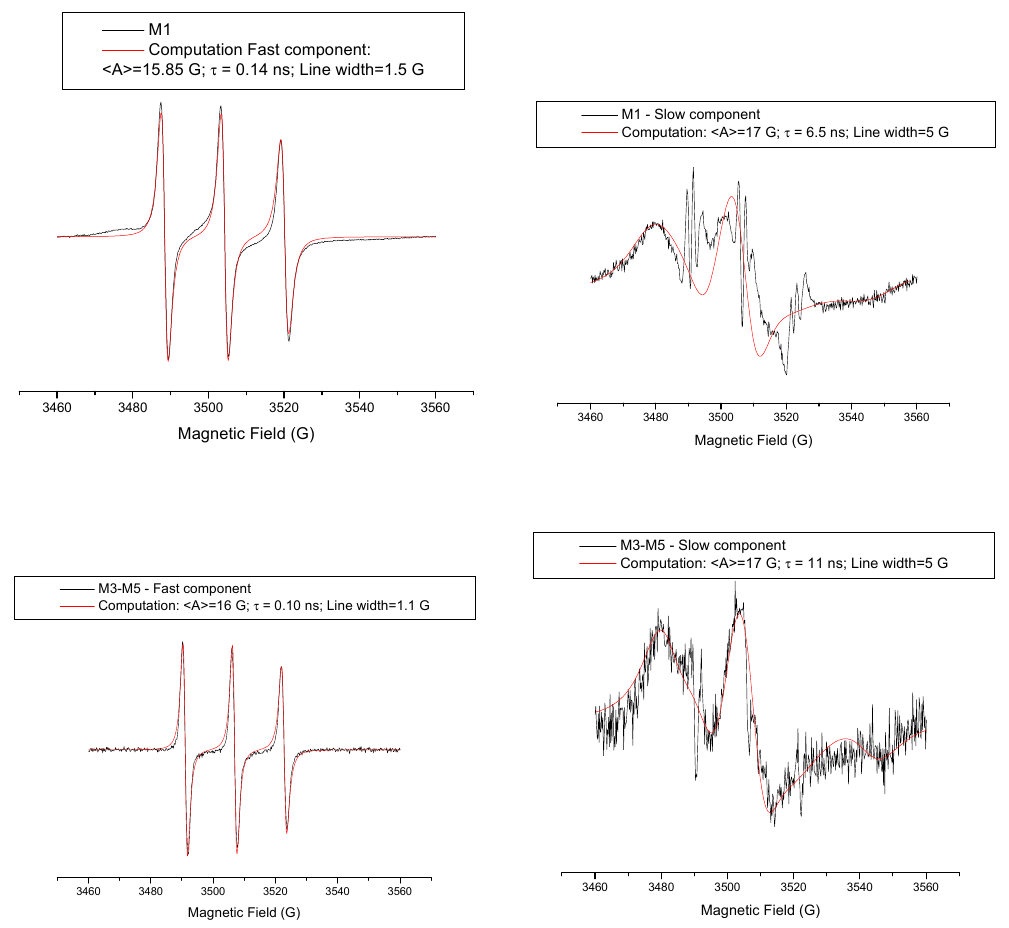
Figure 10. Experimental and computed spectra (extracted slow and fast component) for the probe 4C-T interacting with the dyes M1 , M3 , and M5.